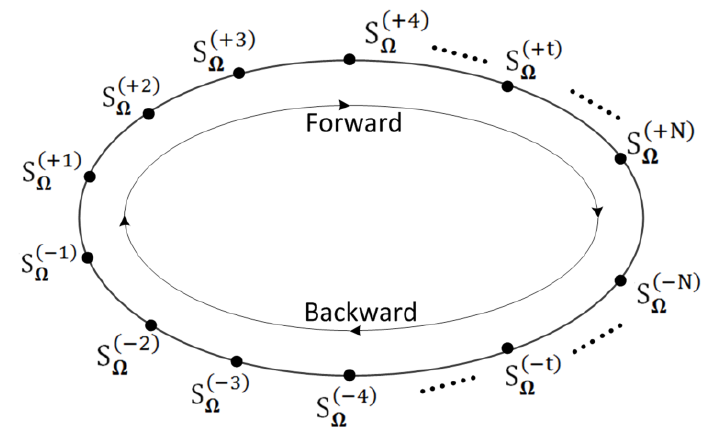
(+ t ) ( − t ) and S denote the pixel state estimation results of the Ω Ω